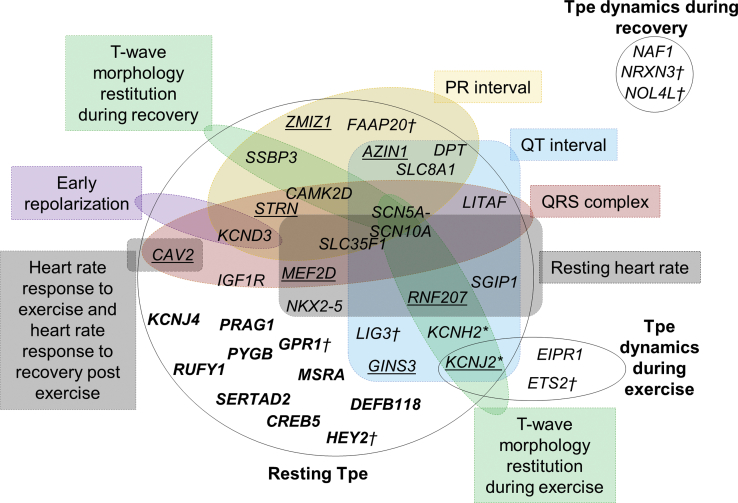
Overlap of Resting Tpe, Tpe Response to Exercise, and Tpe Response to Recovery Loci with Other Electrocardiogram TraitsSNVs at loci with a known genome-wide significant association (from PhenoScanner or GWAS catalog) with other ECG traits are grouped accordingly. The locus names indicate the nearest coding genes. The KCNJ2 locus was shared between resting Tpe and Tpe dynamics during exercise. There was no loci overlap between Tpe response to recovery and resting Tpe or Tpe response to exercise. There was a substantial number of loci for resting Tpe that did not overlap with other ECG traits. Underlined loci are loci that have previously been associated with other ECG markers but the reported variant was not in high LD (r2 < 0.8) with our lead variant, so potentially independent signals at those loci. Bold loci are loci that have not been associated with other ECG marker.†Indicates sex-specific loci.∗Indicates previously associated with Tpe interval in other studies (PMID: 20215044 and 22342860).